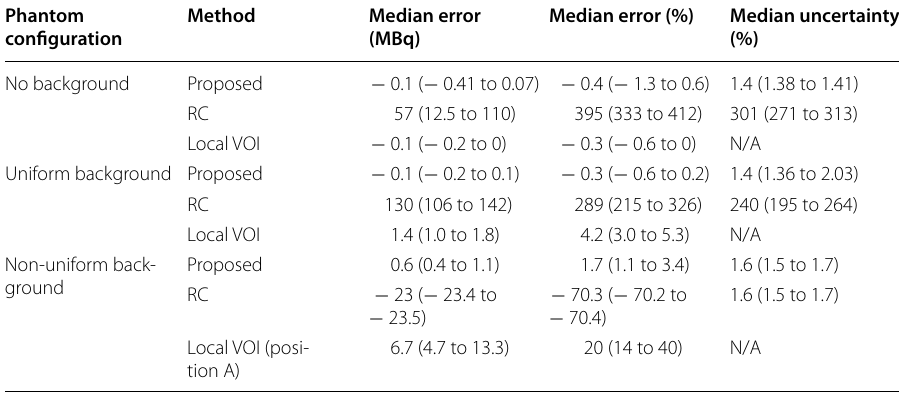
Ranges are given in